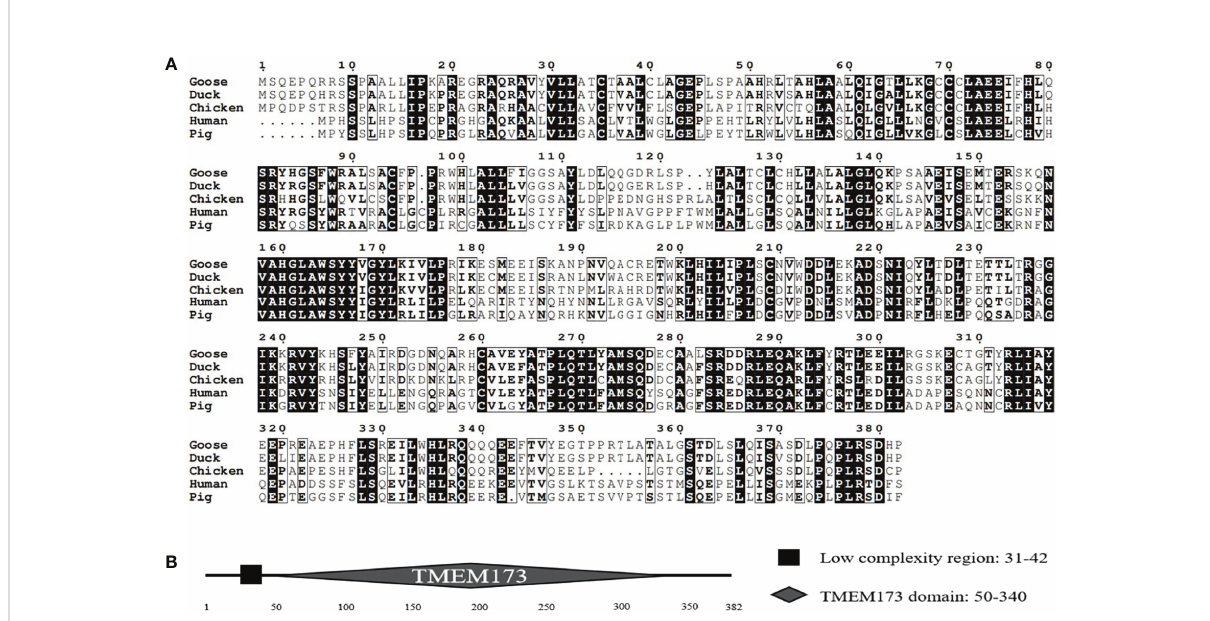
FIGURE 1 (A) The alignment of the deduced amino acid sequence of GoSTING with other animal STING proteins from the ducks, chickens, humans, and pigs was performed using the Clustal W program and edited with ESPript 3.0. The black shading indicates the identity of the amino acid, and the gray shading indicates similarity. (50% threshold). (B) The prediction of protein domains of